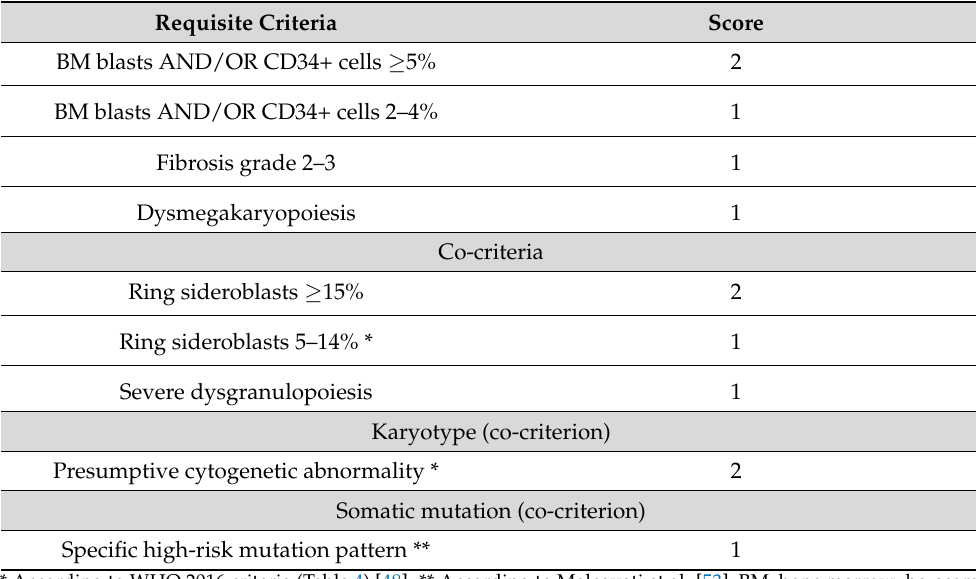
Table 7. Integrated cyto-histologic/genetic score for distinction of non-malignant bone-marrow failure syndromes and hypoplastic